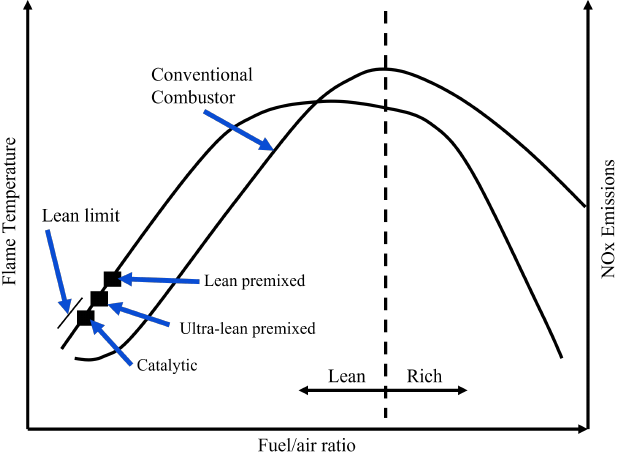
Figure 14. Air/fuel ratio effect to flame temperature and NOx